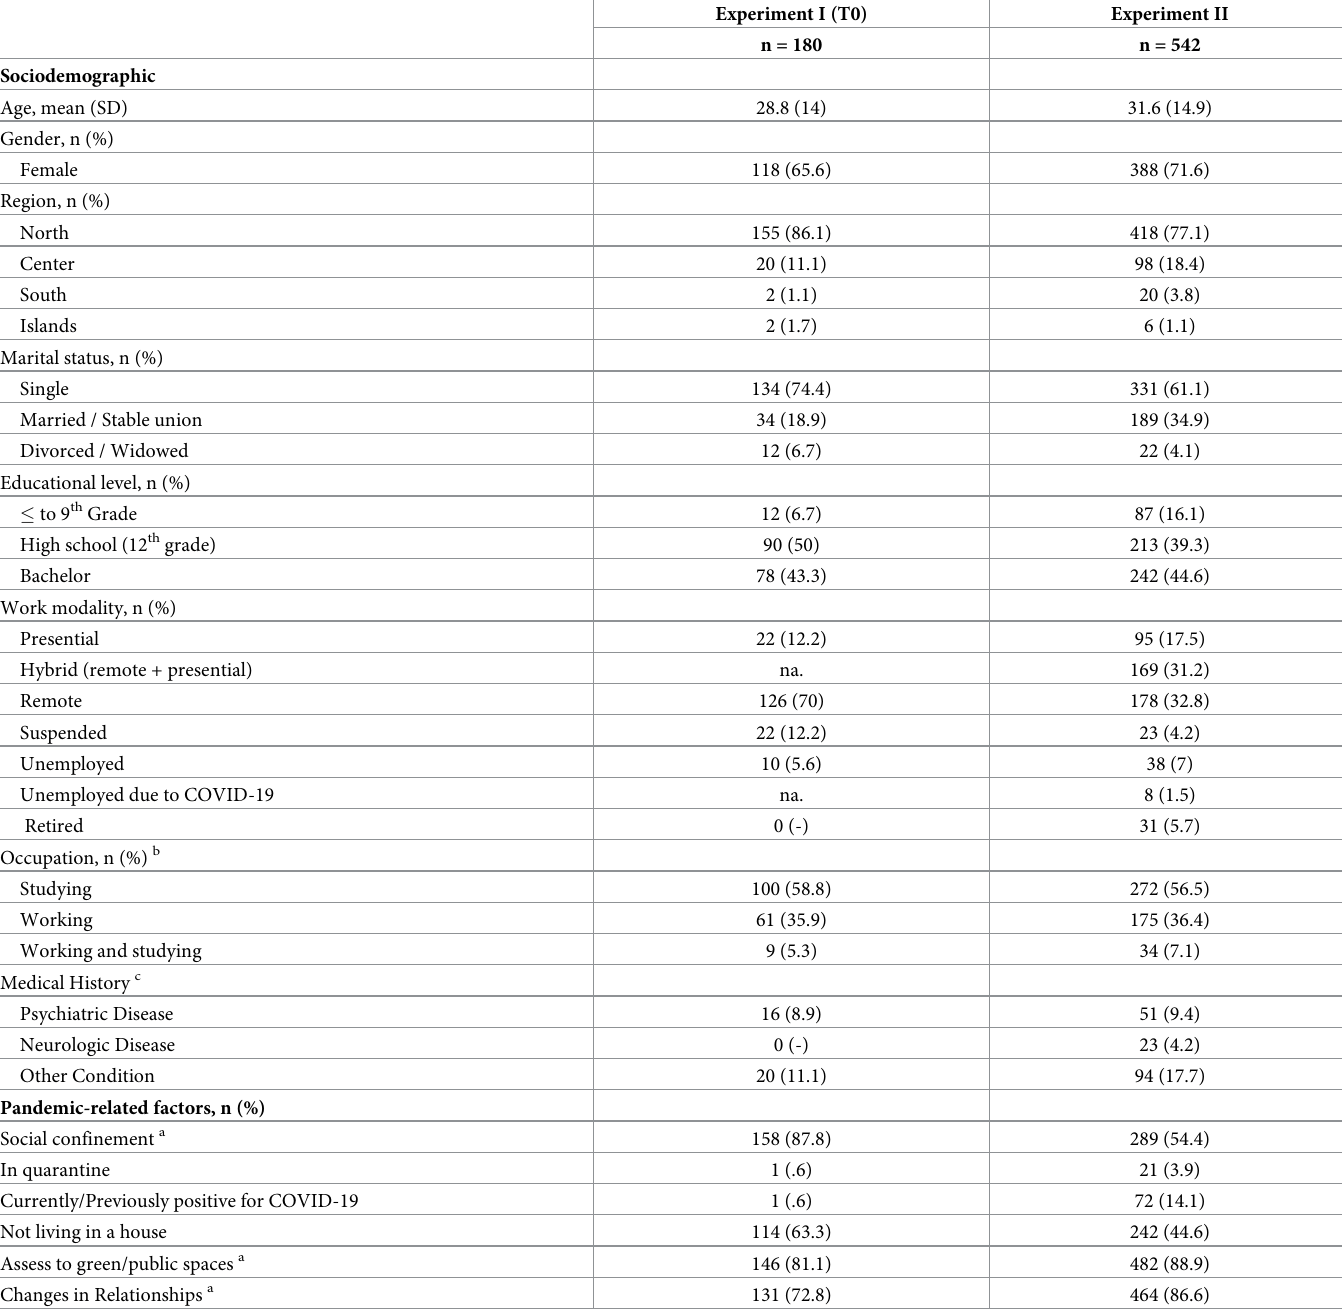
Table 1. Distribution of sociodemographic and pandemic-related factors at Experiment I (T0) and Experiment